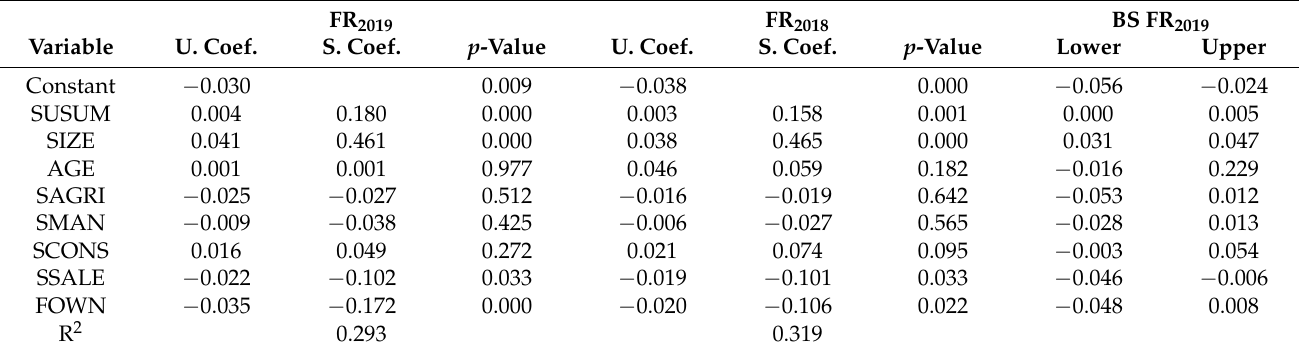
Table 7. Models with SUSUM as the independent variable (N =